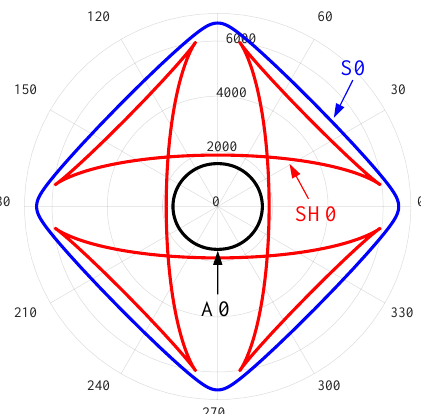
Figure 17. Group velocity directivity curves at 330 kHz in a 1.6 mm cross-ply CFRP plate.